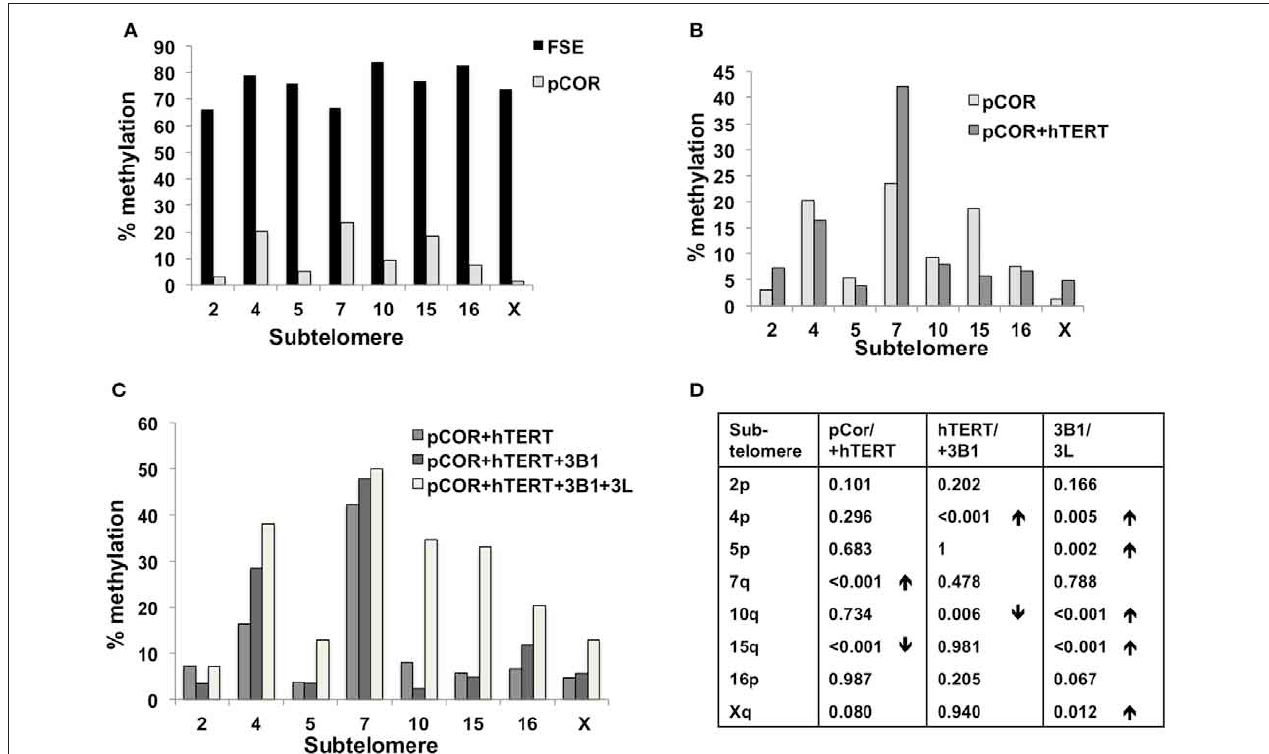
FIGURE 7 | Bisulfite analysis of subtelomeric methylation in ICF fibroblasts. pCor fibroblasts were subjected to bisulfite analysis at eight subtelomeric regions (2p, 4p, 5p, 7q, 10q, 15q, 16p, and Xq), within 400bp from the respective telomeric track. Regions are depicted in graphs by chromosome number only, but refer only to the specified chromosome arm. Bisulfite analysis data appears in Figures A1 – A9 and in Table A1 . (A) Comparison of subtelomeric methylation levels between WT (FSE) and ICF (pCor) fibroblasts. (B) Comparison of subtelomeric methylation levels between pCor fibroblasts and pCor + hTERT fibroblasts. (C) Comparison of subtelomeric methylation levels between